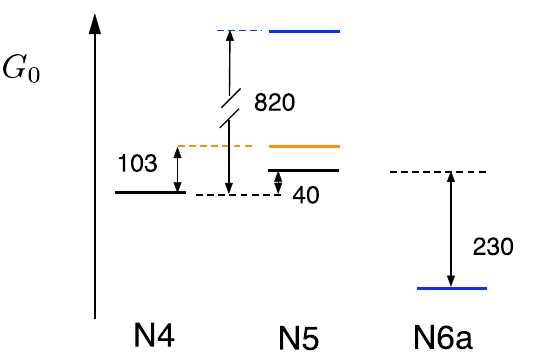
Figure 5. Free energy profile. Δ G 0 calculated from equation (7) assuming Δ G redox = 0. The values of Δ G 0 are shown in meV for electron on N4 (black), on N5 (blue), and on N6a (orange). The transition of the second electron to N5 − is prohibited by a very high uphill free energy of ∼ 820